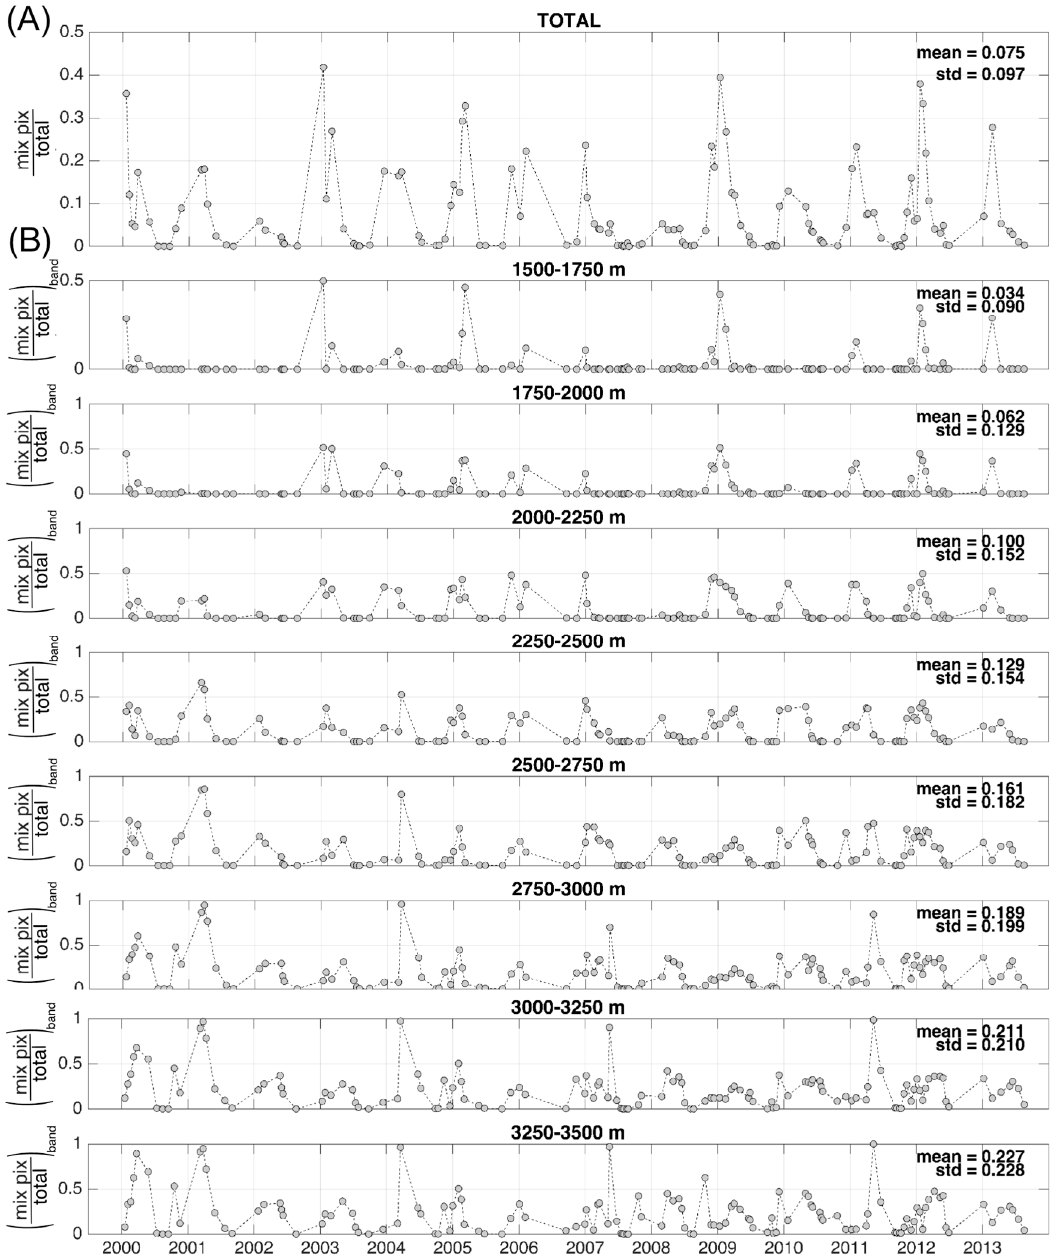
Figure 9. ( A ) Temporal evolution of the fraction of mixed pixels at the Sierra Nevada range during the study period for the whole study area (number of mixed pixels/total pixels) and ( B ) distributed within 250 m-range elevation bands (number of mixed pixels/pixels in the elevation band).